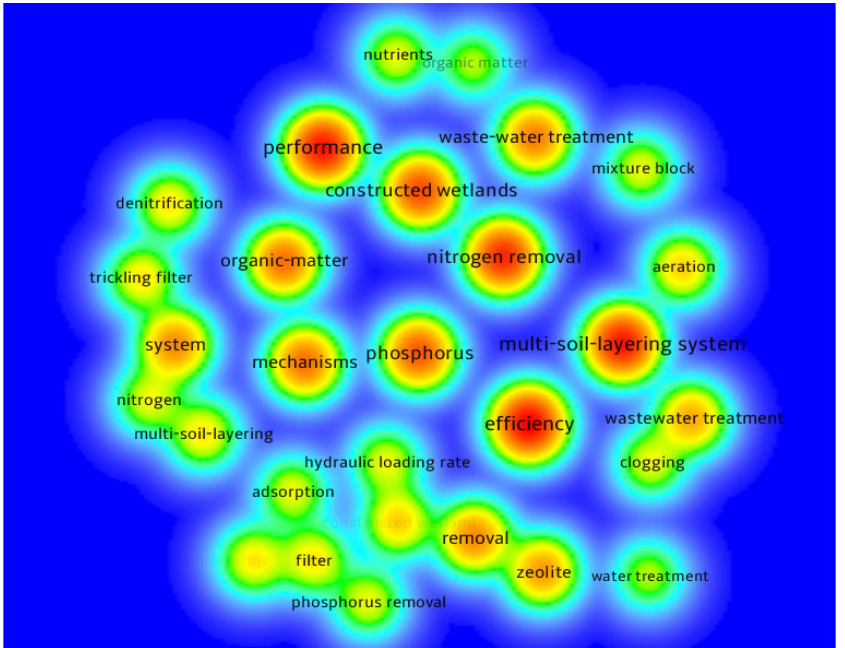
Figure 3. Co ‐ occurrence analysis map using density visualization. Red circles (hotspots) with large labels reflect the most often occurring items compared to those represented by colored circles ranging from green to blue with small labels. In the co ‐ occurrence map, some extracted items are hidden to avoid overlapping.